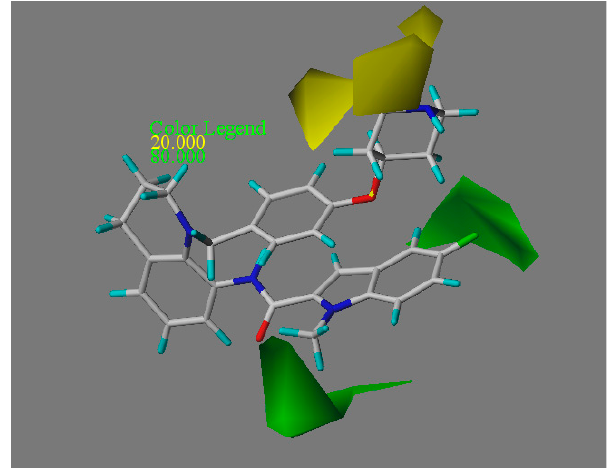
Figure 3. The CoMFA model contour map with compound 18x as the reference. The contour maps of the CoMSIA model are shown in Figure 4. The steric field contour map of CoMSIA (Figure 4A) was extremely similar to that of CoMFA. For the hydrophobic field (Figure 4B), a hydrophobic substitution would be favorable for the activity in the yellow surface and unfavorable for the activity in the white surface. Clearly, a hydrophobic group substitution near the R1 group is beneficial to the inhibitory activity, which is supported by the followed activity order: compound 3 (with an N atom at R1) > compound 11 (with an -NH 2 group at R1) and compound 4 (with an N atom at R1) > compound 6 (with an -NH 2 group at R1). Figure 4C shows the contour map of